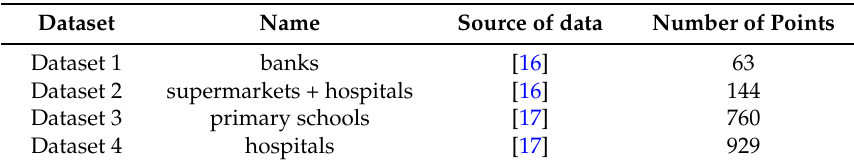
Table 1. Datasets used in the test.